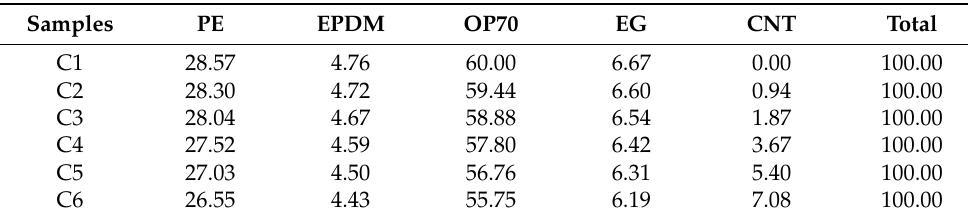
Table 2. Mass percentage of the as-prepared thermal conductivity enhanced phase change composite material samples